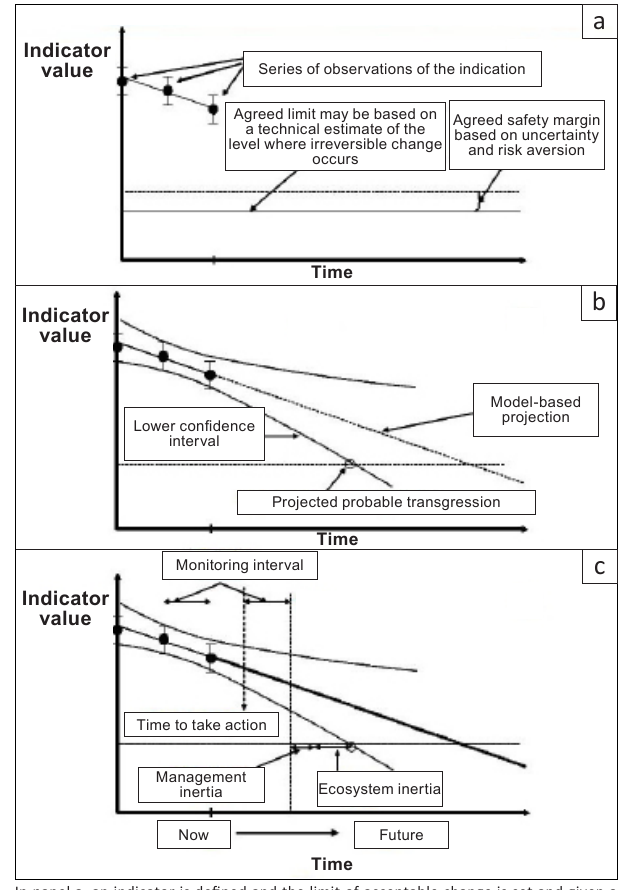
FIGURE 1: Steps in establishing a management action